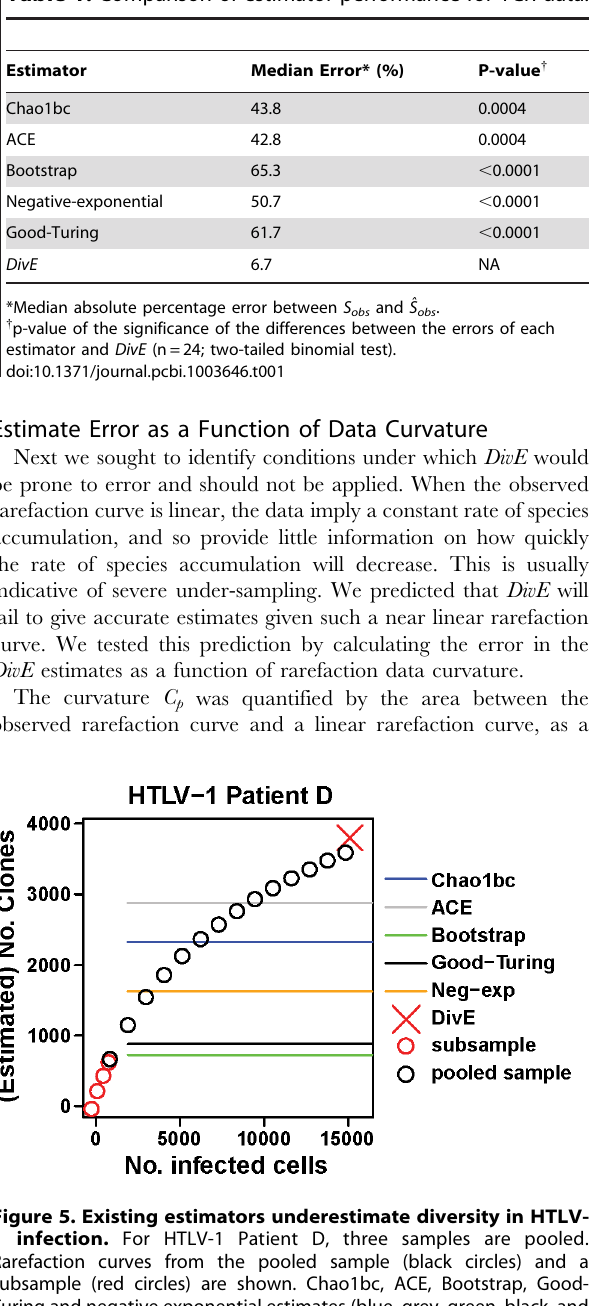
Table 1. Comparison of estimator performance for TCR data.